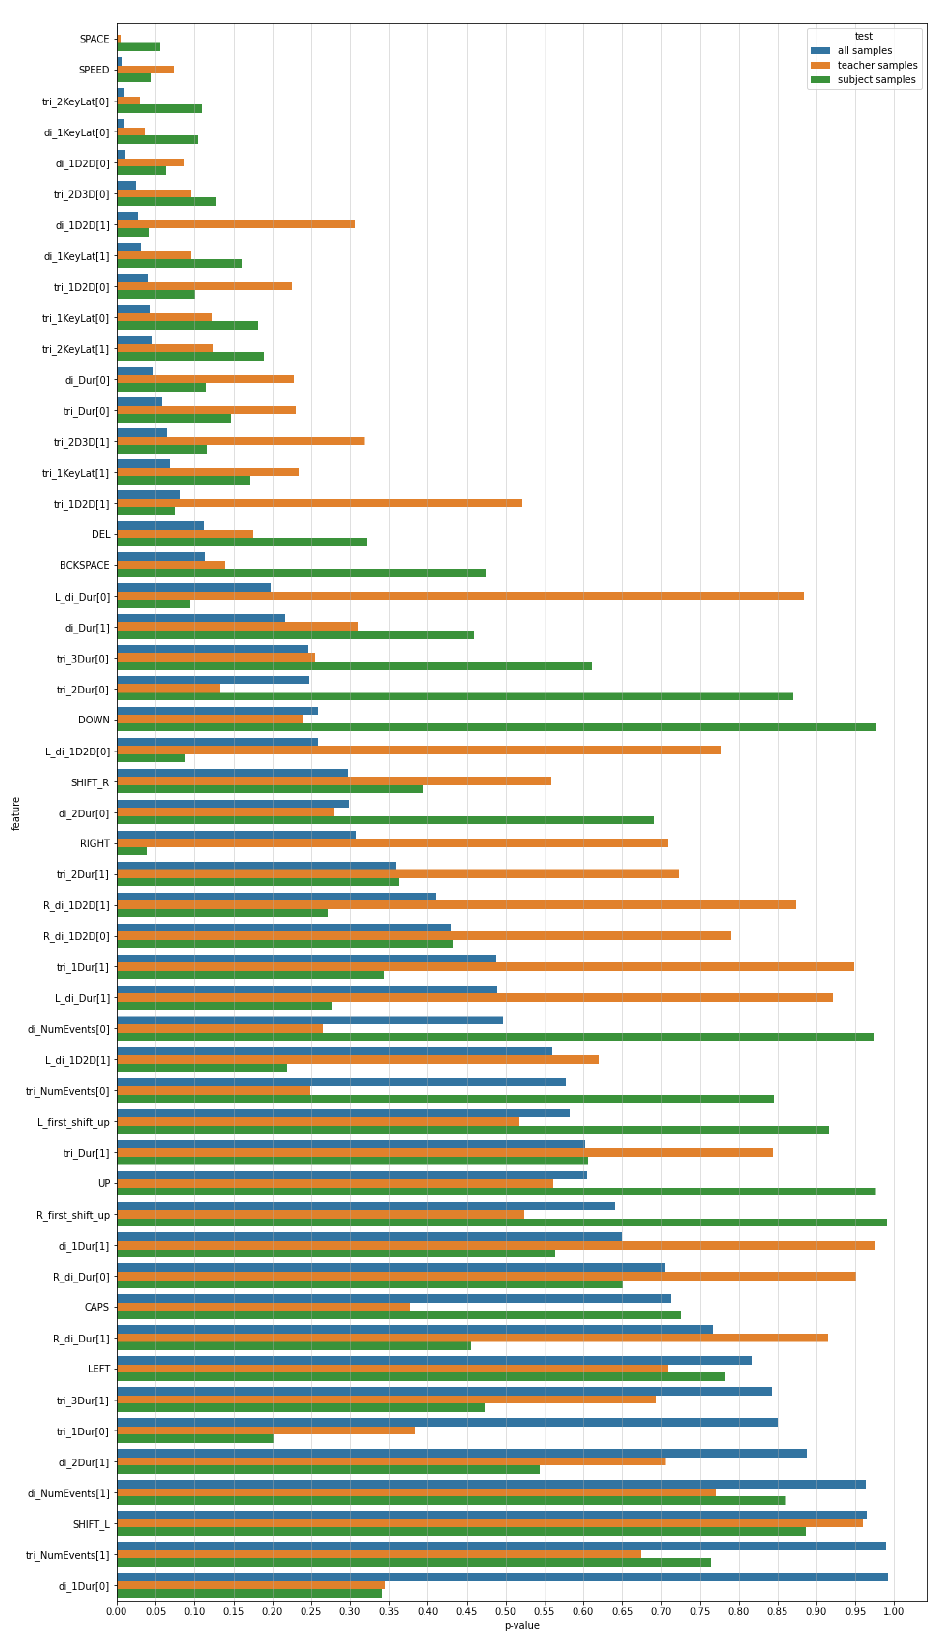
Figure 6. p -values obtained after applying paired t -test for positive/negative opinions on the basis of three sets of samples. Features are sorted according to the results obtained on the basis of a dataset containing all